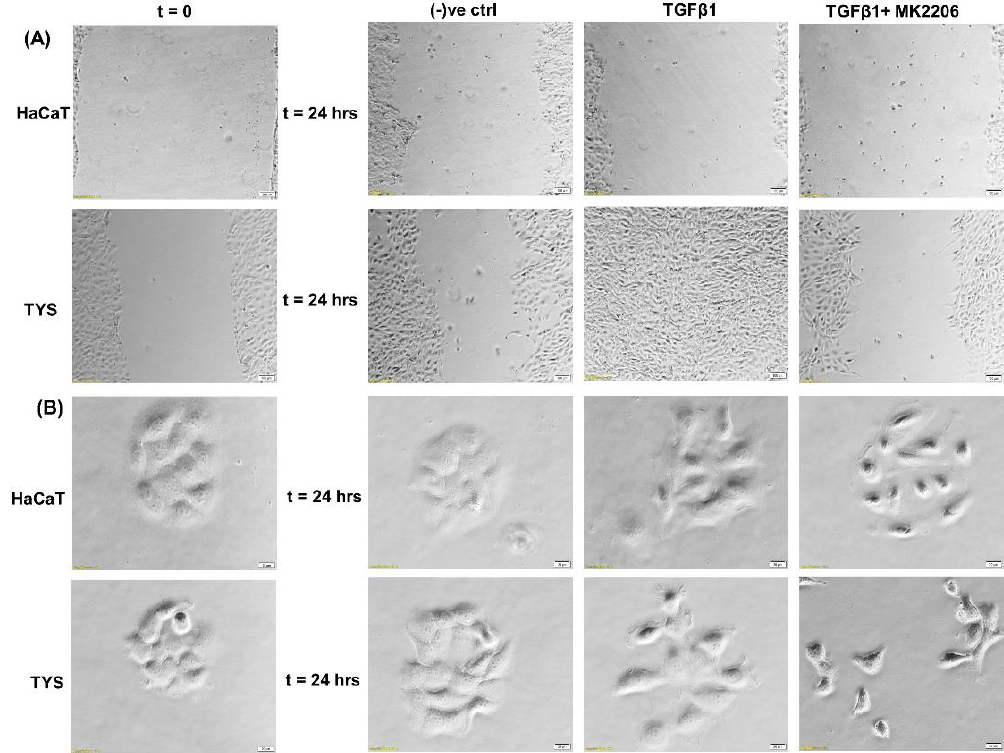
Figure 5. Oral cancer cell migration in response to TGFβ. ( A ) TGFβ with or without the inhibitor was used in the wound healing assay for 24 h. TGFβ -stimulated TYS cell migration in the wound healing assay was compared to the negative control. The Akt inhibitor, MK2206, effectively blocked TGFβ -induced oral cancer cell migration. Normal keratinocytes (HaCaT) were not stimulated to migrate in response to TGFβ . Serum-free medium was used as the negative control. Images were captured at t = 0 and 24 h at 50× magnification. ( B ) Cells were plated at low density to form small colonies of cells for the scatter assay and were then treated with the test conditions for 24 h. TGFβ stimulated TYS cells to migrate away from the compact colonies. However, MK2206 did not block TGFβ -induced scattering of oral cancer cells. HaCaT cells were not stimulated to scatter in response to exogenous TGFβ . Serum-free medium was used as the negative control. Images were captured at t = 0 and 24 h at 200× magnification. An inverted microscope (Olympus IX70, Tokyo, Japan) with a brightfield camera (SC50) was used to capture the images and CellSense software (Olympus) was used to process the images. The experiments were carried out more than 3 times.